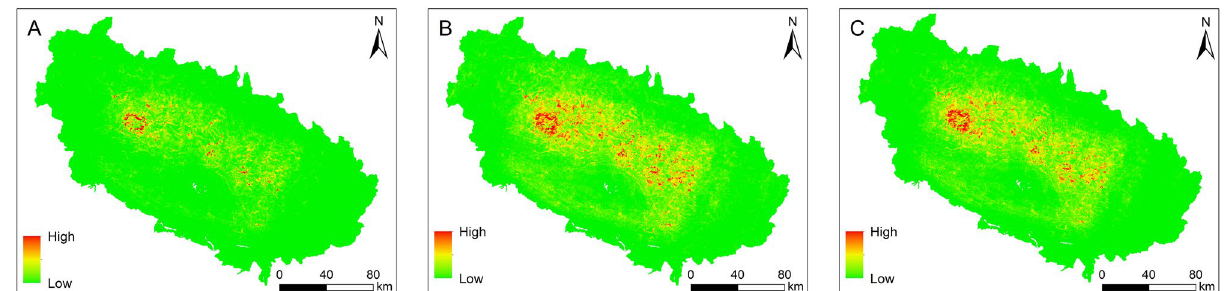
Figure 9. Landslide susceptibility maps obtained within the LR model for the three larger inventories ( A – C ) considered in this work ( cf. Figure 3). 0 and 1 represent lowest and highest value of LS respectively. The maps were created using ArcGIS version 10.8.1 (https:// www. esri. com/).